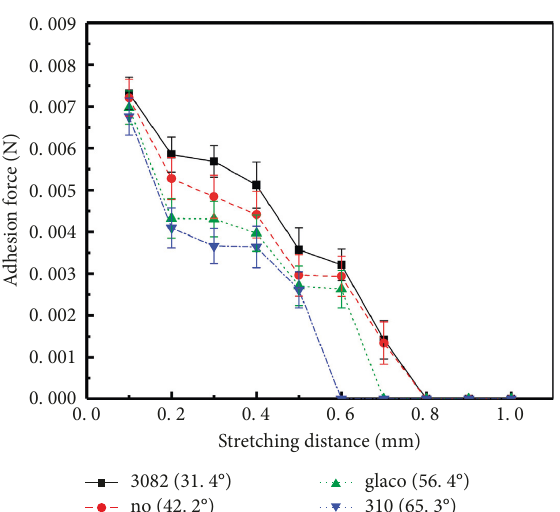
Figure 18: Variation curve of adhesion force with stretching distance of liquid bridge under different contact angles.